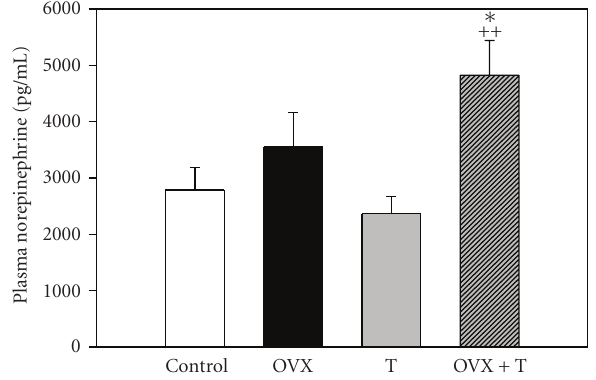
Figure 3: Plasma norepinephrine at the end of the experiment by treatment group (means ± S.E.M.). Open bars: controls, n = 8, solid black bars: ovarectomy (OVX, n = 6), gray bars: testosterone treated (T, n = 6), striped bars: ovarectomy and testosterone treatment (OVX+T, n = 7). One-way ANOVA: H = 9 . 6, df = 3, P < . 05, ∗ P < . 05 compared to controls, ++ P < . 01 compared to testosterone